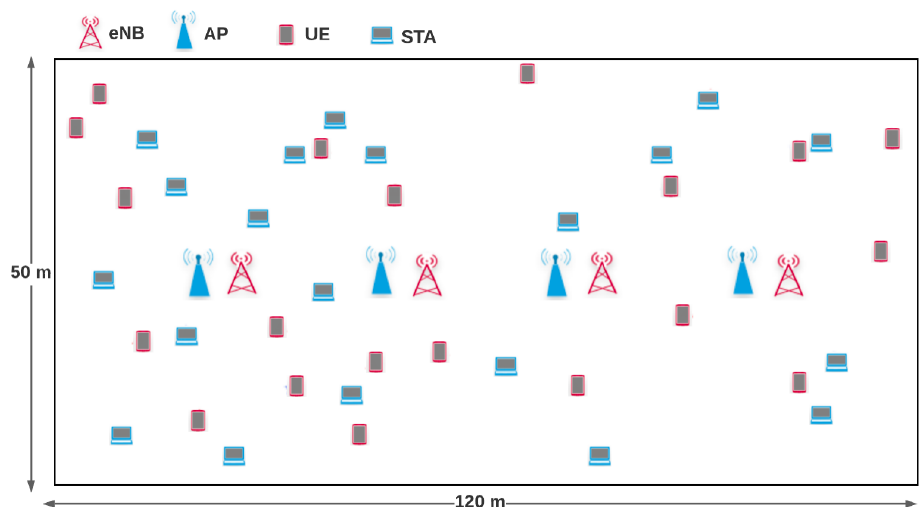
Figure 2. Indoor network scenario based on 3GPP specification [38].